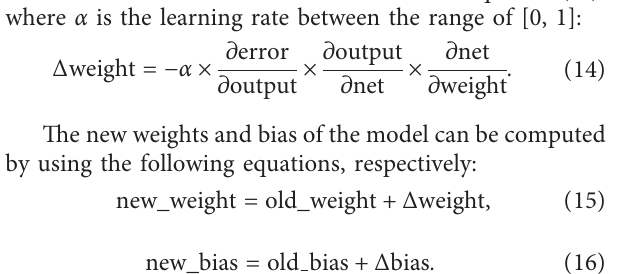
Table 1: Comparison of RMS errors of ANN, NF, ANN-FR, and NF-FR